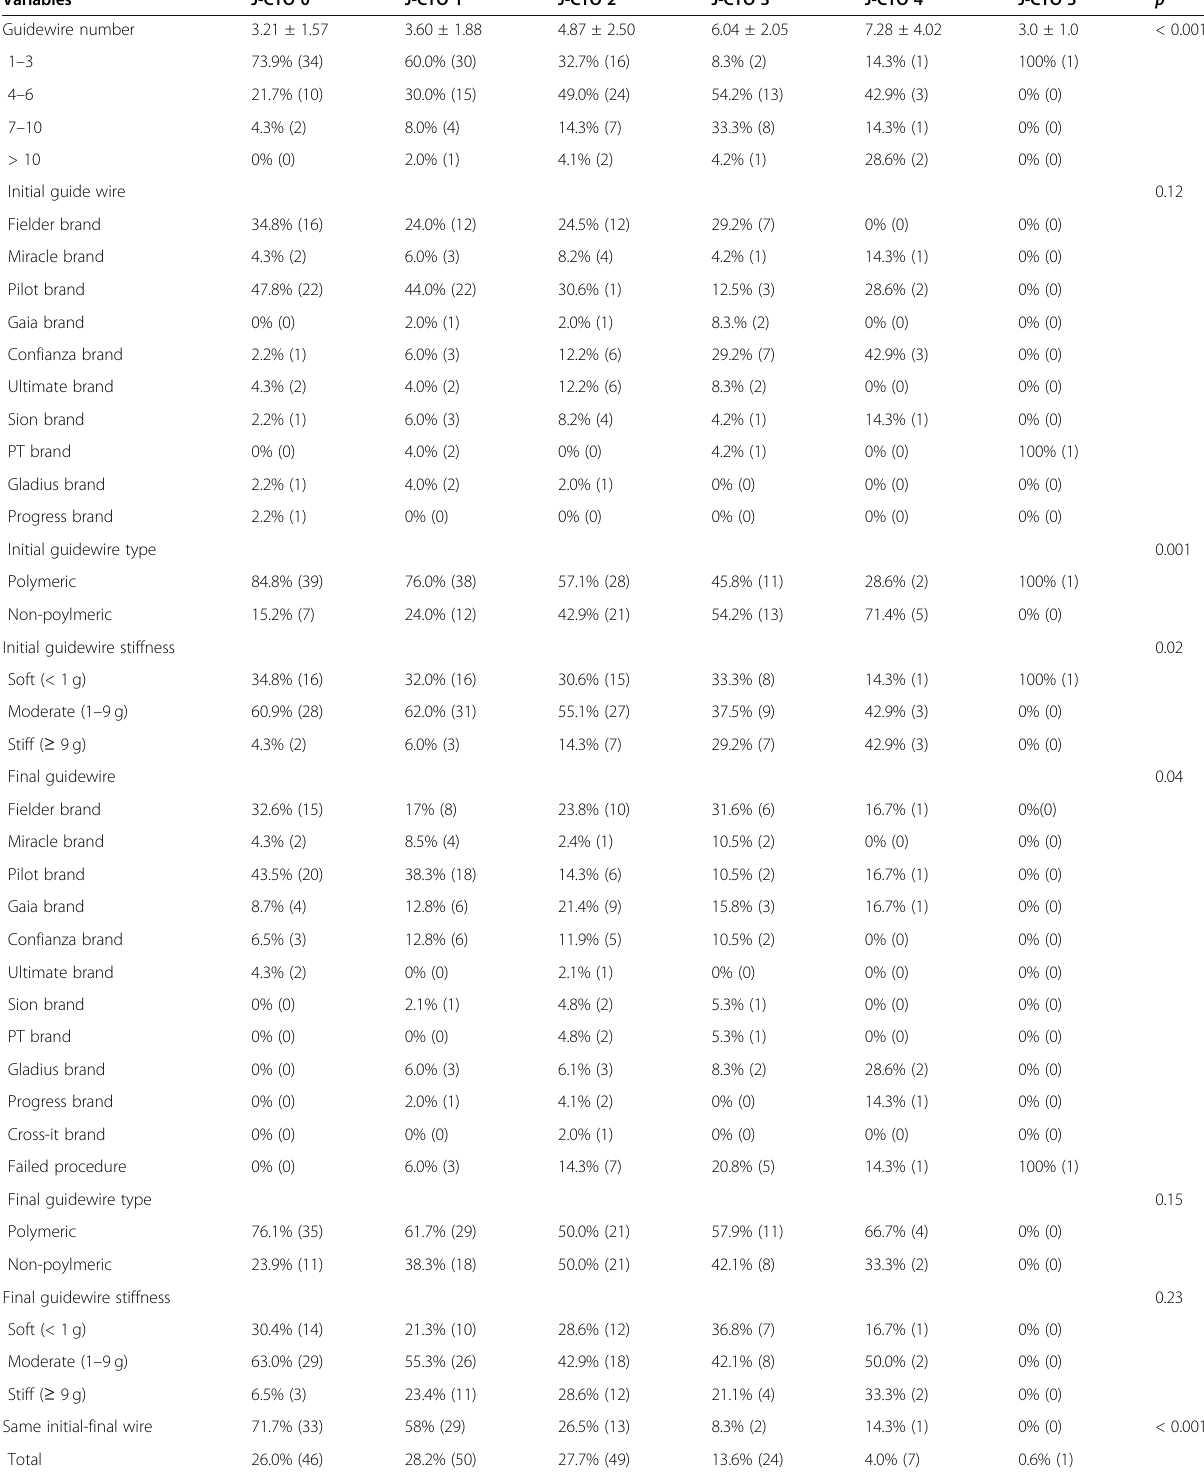
Table 6 Distribution of first-choice and final crossing guidewires characteristics according to J-CTO